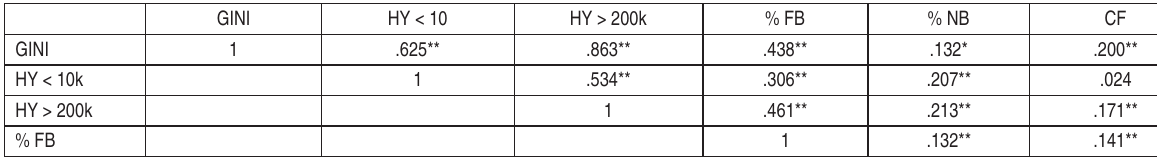
Table 5. Inequality partial